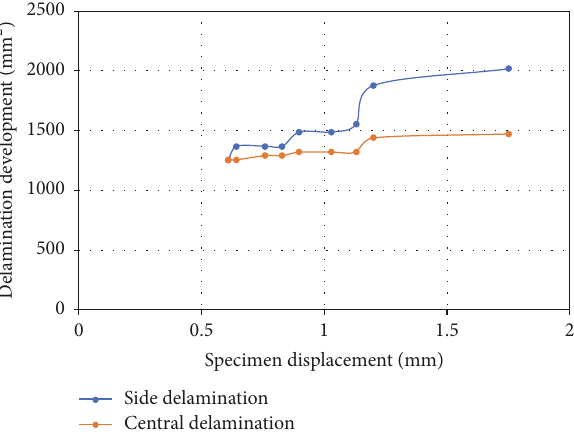
Figure 24: Specimen deformation at buckling, specimen with central